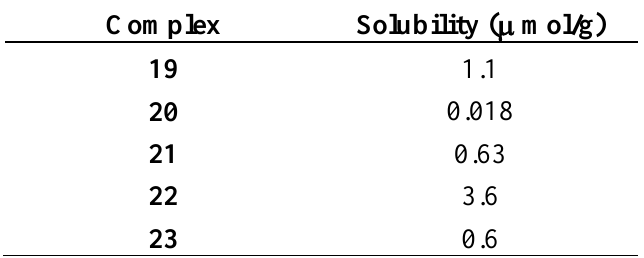
Table 5. The solubility of Tb(III) complexes used in this